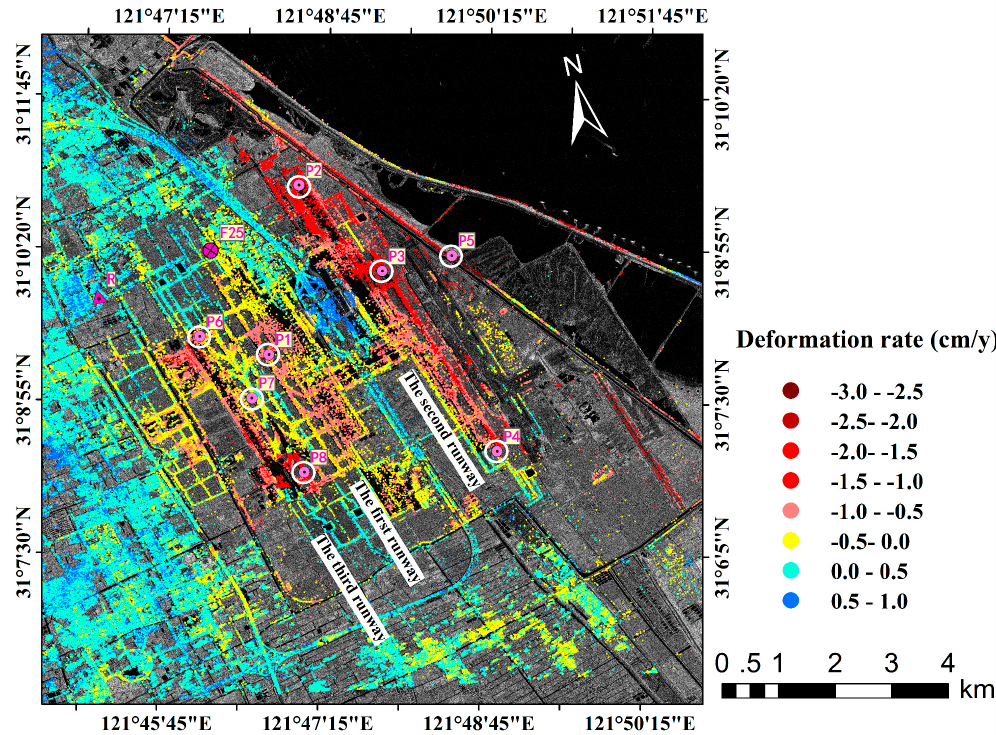
Figure 4. Spatial deformation velocity map of Pudong International Airport.